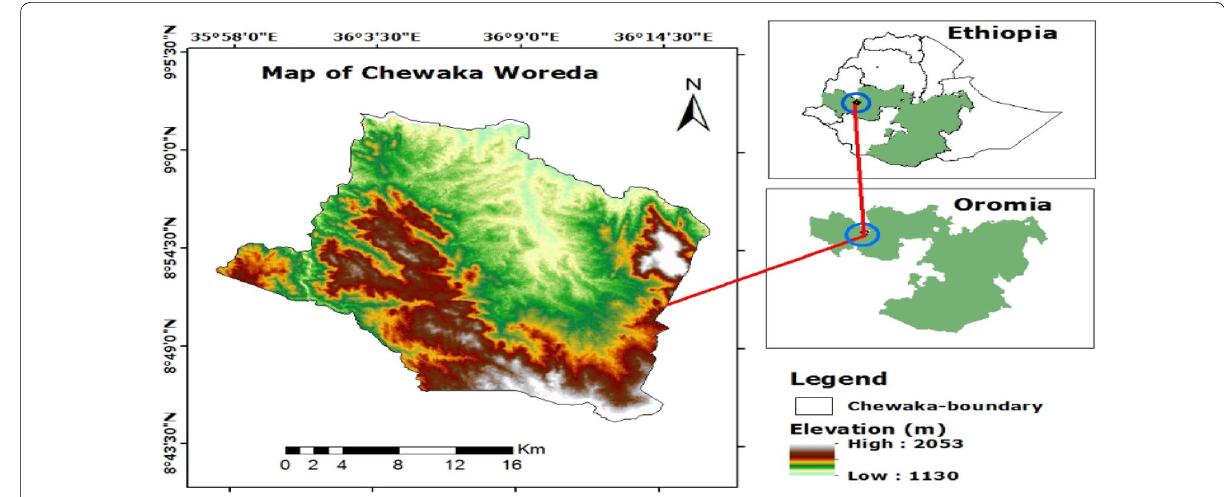
Fig. 1 Location map of the study